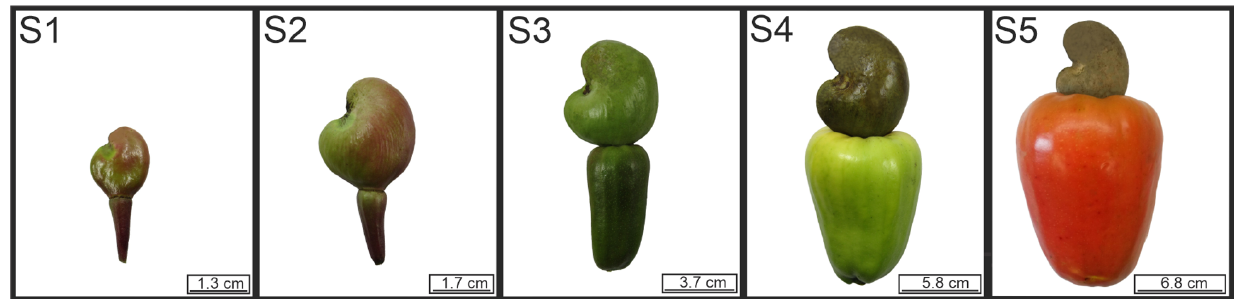
Figure 1. Development and maturation stages of the pseudofruit of CCP 76 cashews. Likewise, skin color underwent significant changes. In S1 and S2, the pseudofruits were brown and changed to yellow tones in S3 and S4, while in S5 the fruit displayed a marked reddish coloration (Figure 1). These changes were reflected in the evolution of color parameters (Figure 2c). Parameters ‘L’ and ‘b’ exhibited a gradual increase as the postharvest period advanced, with values from 25.75 to 63.61 for ‘L’ and from 15.80 to 48.95 for ‘b’. Parameter ‘a’ obtained values of 48.94 in S1, which lowered slightly in S2. Then, a drastic decrease occurred in S3 and S4 (values of − 14.33 and − 15.12), which coincided with the color change to green tones. The fruit also exhibited yellow tones. A significant increase in the ‘a’ value was observed when the fruit turned red in